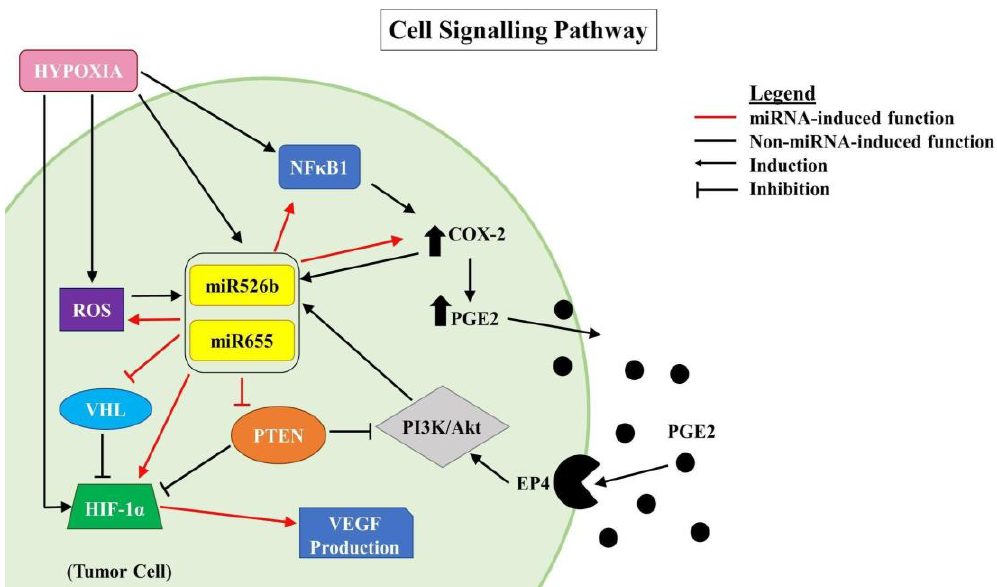
Figure 10. Linking COX-2, EP4, and PI3K/Akt pathways with hypoxia, miR526b, and miR655: red lines indicate functions induced by miR526b and miR655, while black lines indicate functions that are not directly induced by miRNAs. Arrows indicate induction, while T-shaped lines indicate inhibition.